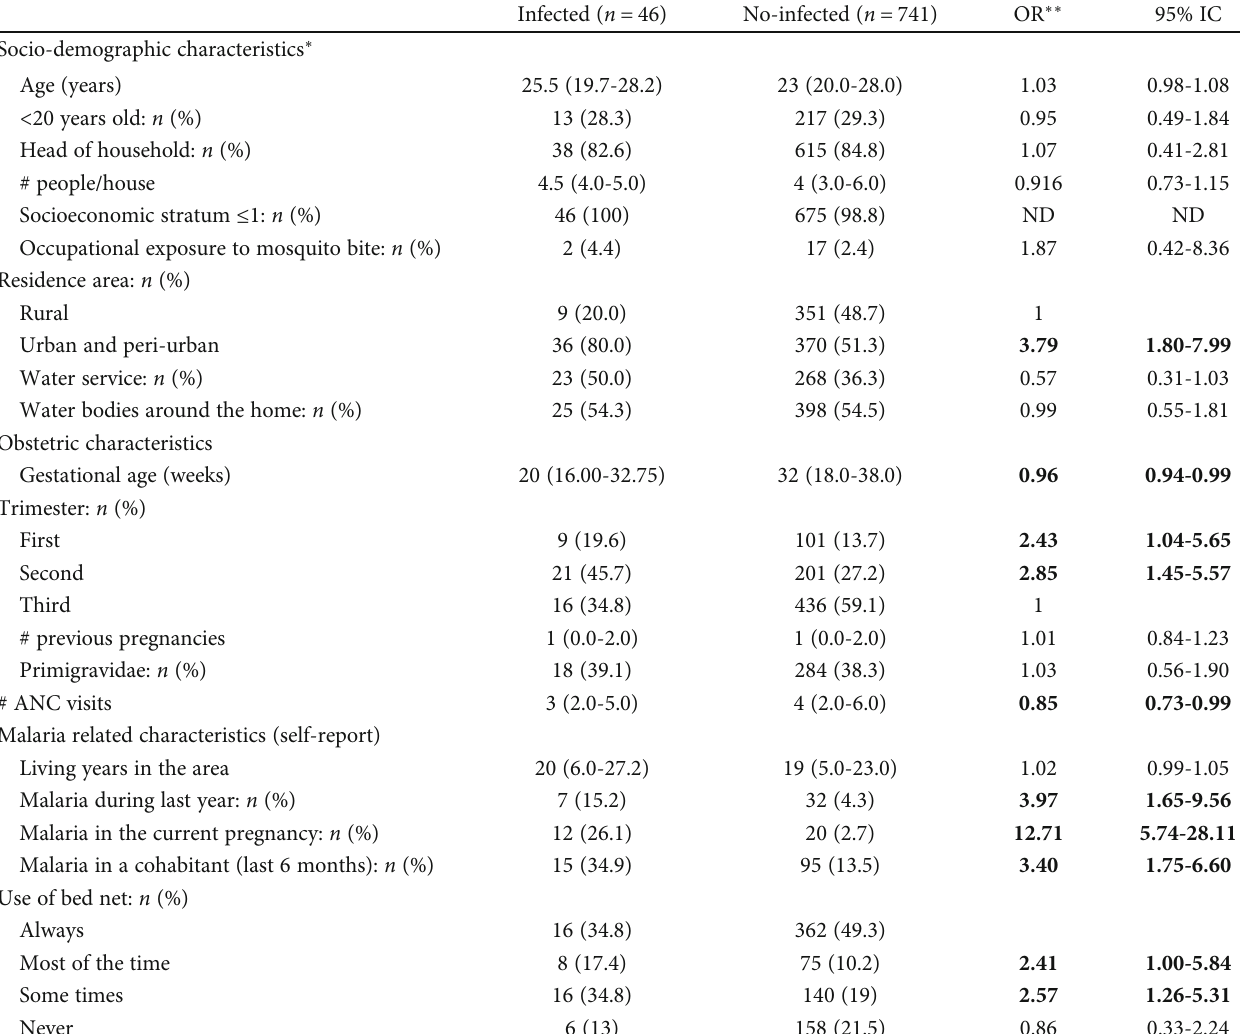
Table 3: Socio-demographic and obstetric characteristics of infected pregnant